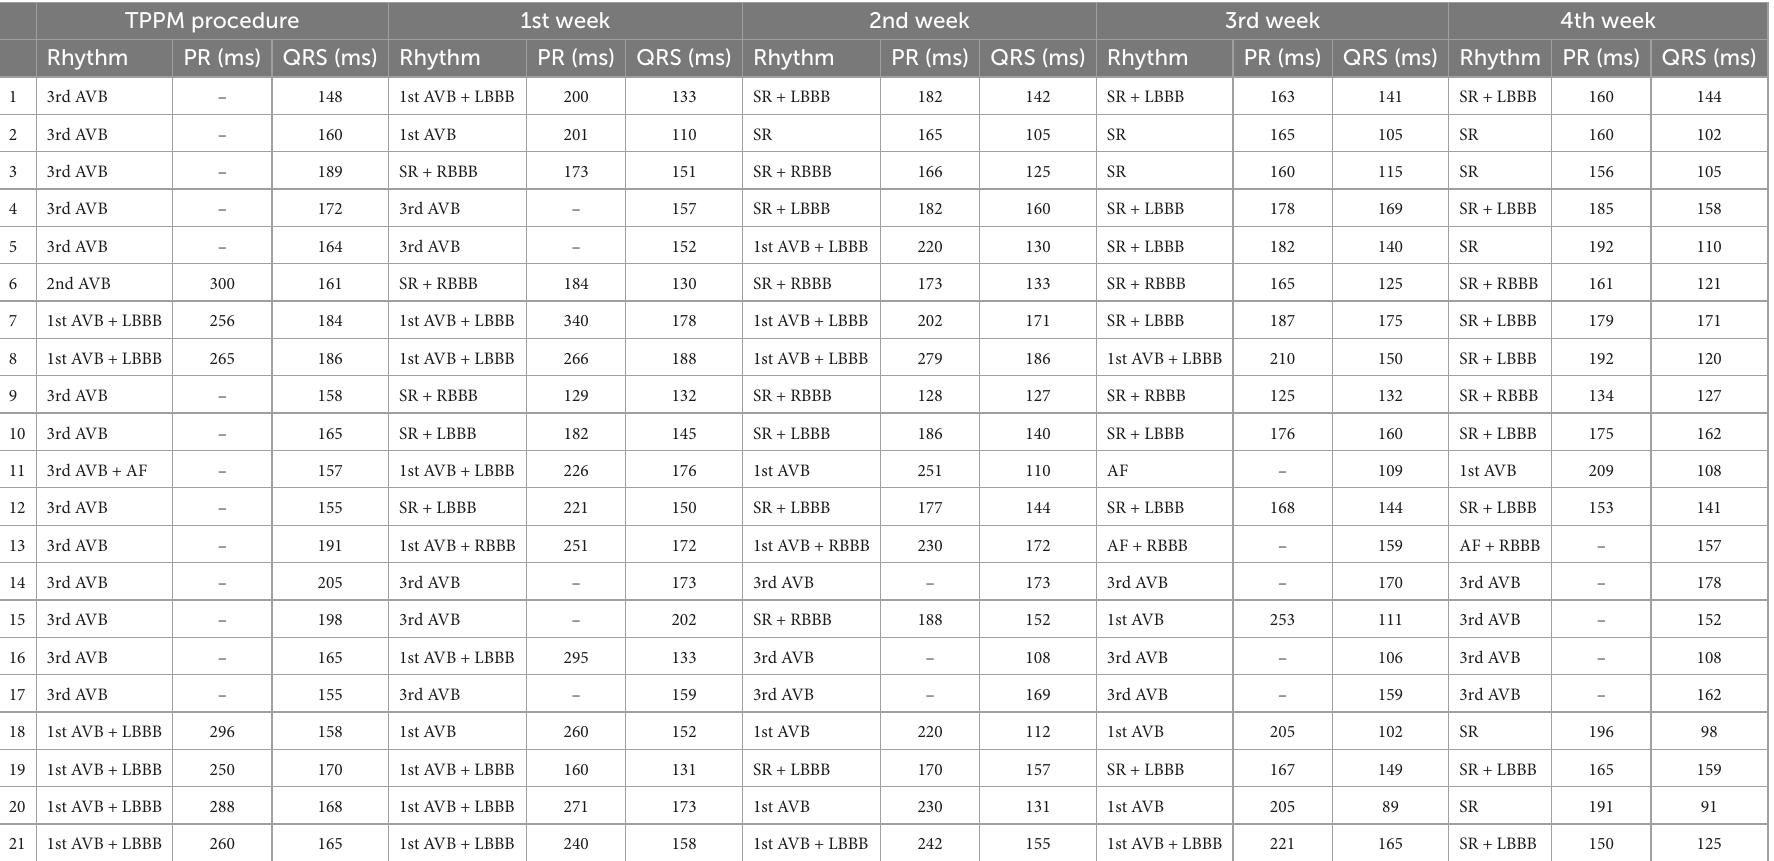
TABLE 3 Changing process of conduction disturbances during follow up for each